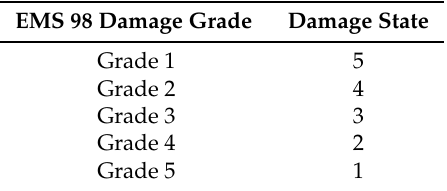
Table 8. European Macroseismic Scale (EMS) 98 damage grades as numbers